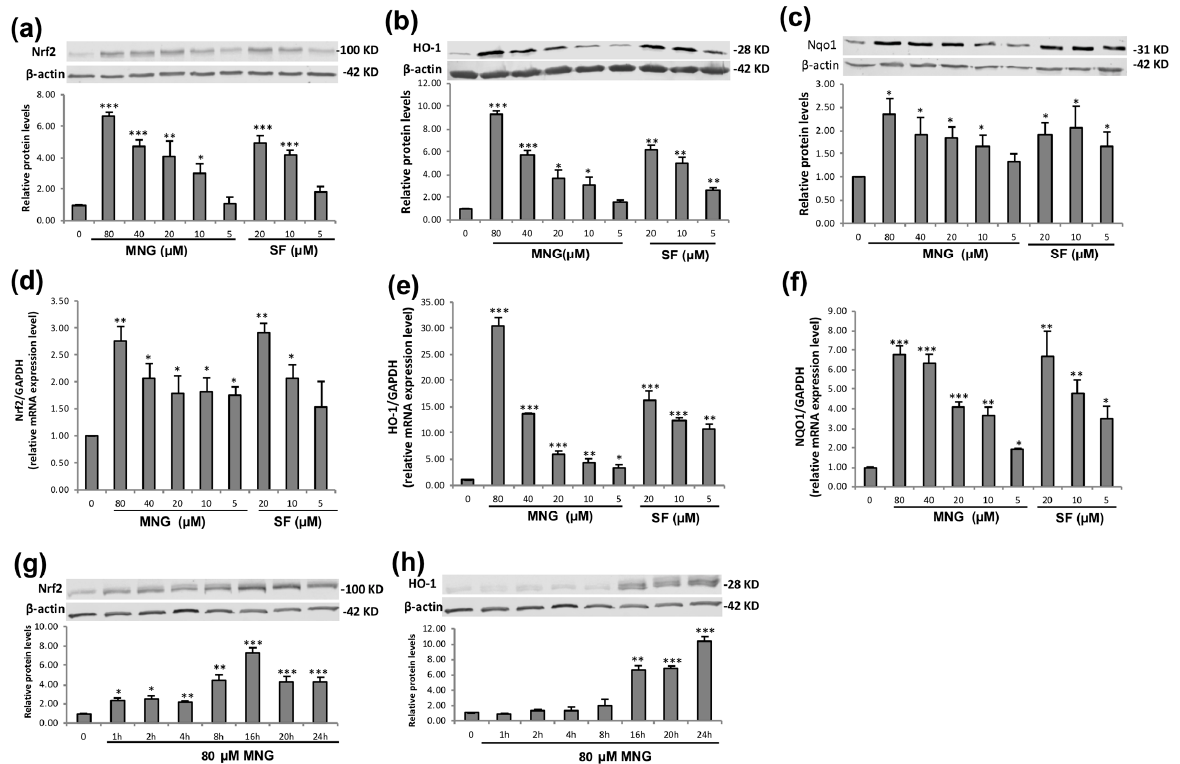
Figure 3. Enhanced expression of Nrf2, HO-1 and NQO1 by MNG in EA.hy926 cells in a dose-dependent manner. ( a – c ) The cells were treated for 24 h with MNG and SF at the indicated concentrations. The protein expression of Nrf2, HO-1 and NQO1 was analyzed by Western blot. An equal amount of protein from whole cell lysates was loaded and the β -actin protein level was considered as an internal control. SF was used as a positive control. ( d – f ) Total RNA was extracted from EA.hy926 cells treated as indicated. The mRNA expression of Nrf2, HO-1 and NQO1 was determined by real-time qPCR. SF was used as a positive control. ( g , h ) EA.hy926 cells were treated with 80 μ M MNG for the indicated durations. The Nrf2/HO-1 protein expression was analyzed by Western blot. The data in the figure represent the mean ± SEM of 3 independent experiments. * p < 0.05, ** p < 0.01 and *** p < 0.001 compared with the control group.